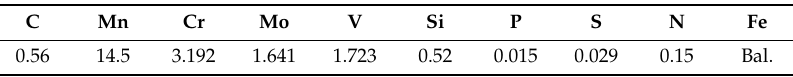
Table 1. Chemical composition of tested steel (mass